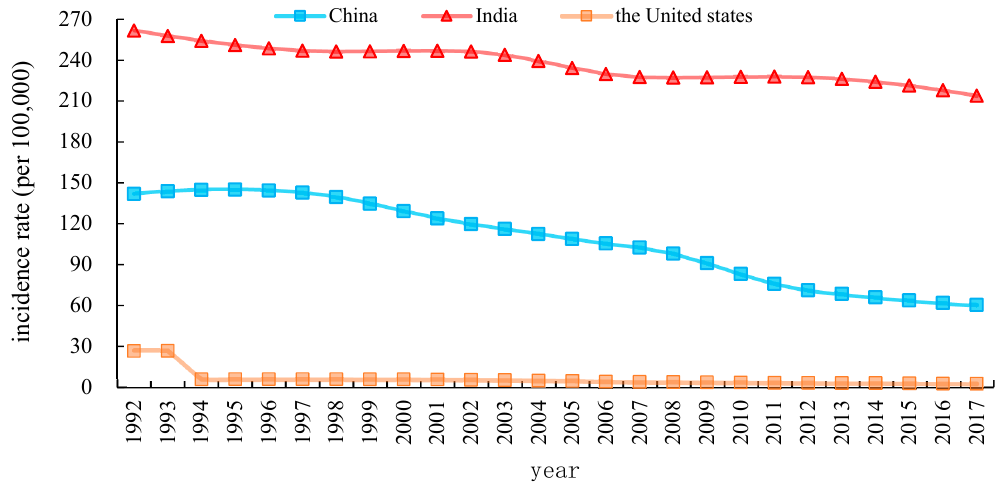
Figure 1. Trends in crude incidence rate (CIR) from tuberculosis (TB) in China India and the United States, 1992 to 2017.